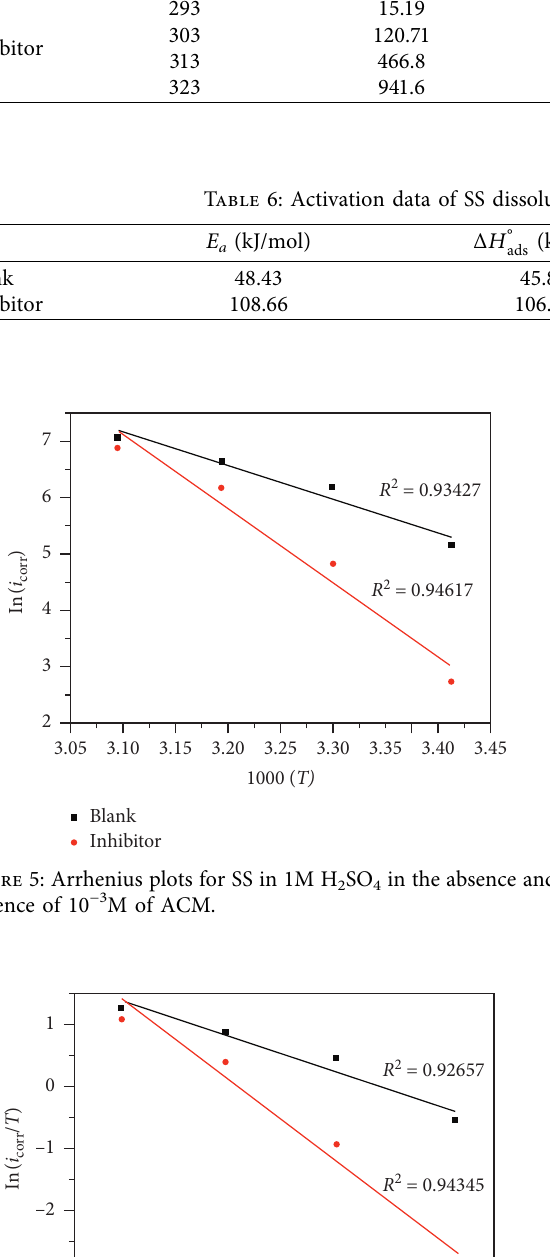
2 SO 4 in the absence